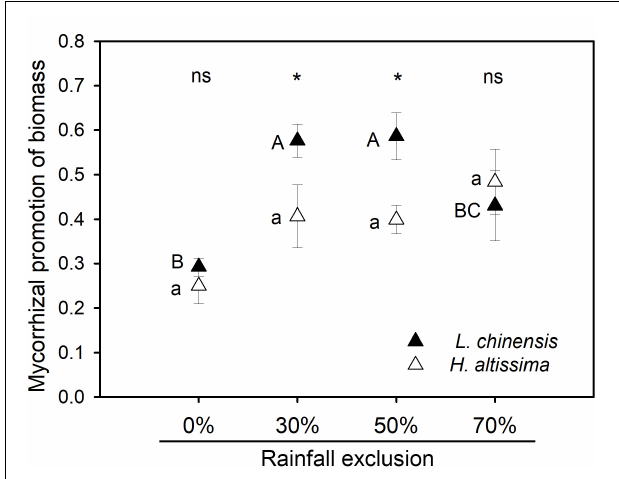
FIGURE 4 | Mycorrhizal response of biomass in L. chinensis and H. altissima . Mycorrhizal benefit existed when values of mycorrhizal response were greater than zero. Different lowercase and capital letters indicate significant differences ( P < 0.05) among the rainfall exclusion treatments in H. altissima and L. chinensis , respectively. ∗ P < 0.05 indicates significant and ns ( P > 0.05) indicates no differences between L. chinensis and H. altissima . Data are reported as mean ± 1 SE ( n =